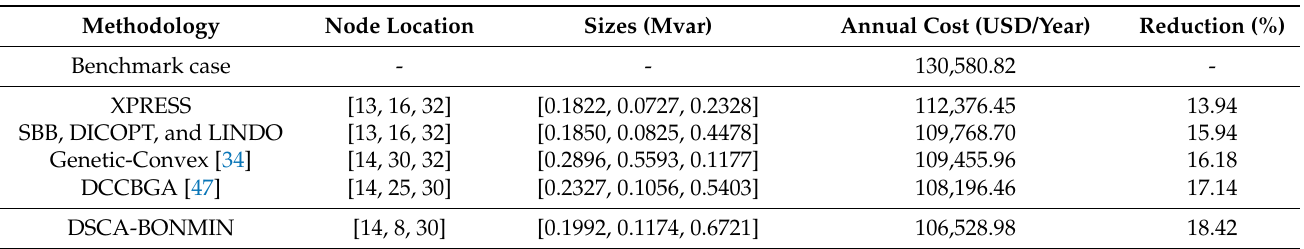
Table 6. Results obtained by the metaheuristic optimizers and the proposed methodology for the radial